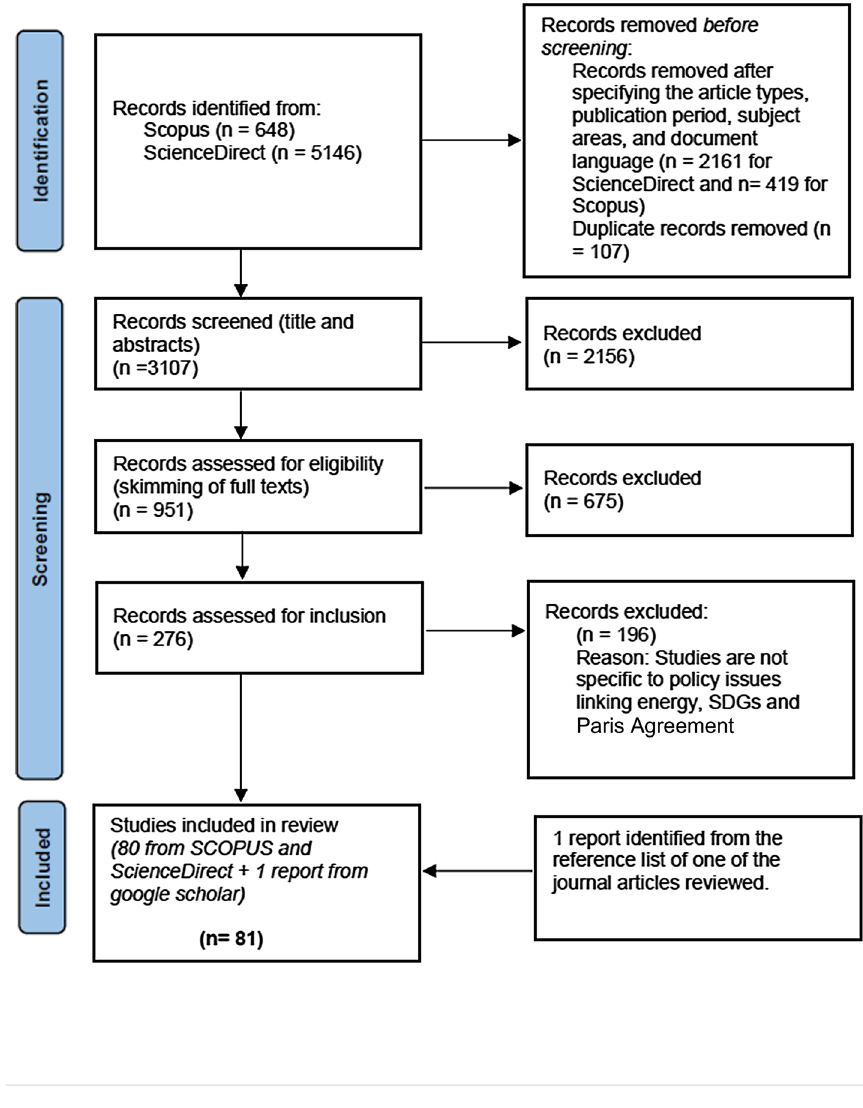
Fig. 1 Document identifica- tion and selection process. Adapted from Page et al. [10]